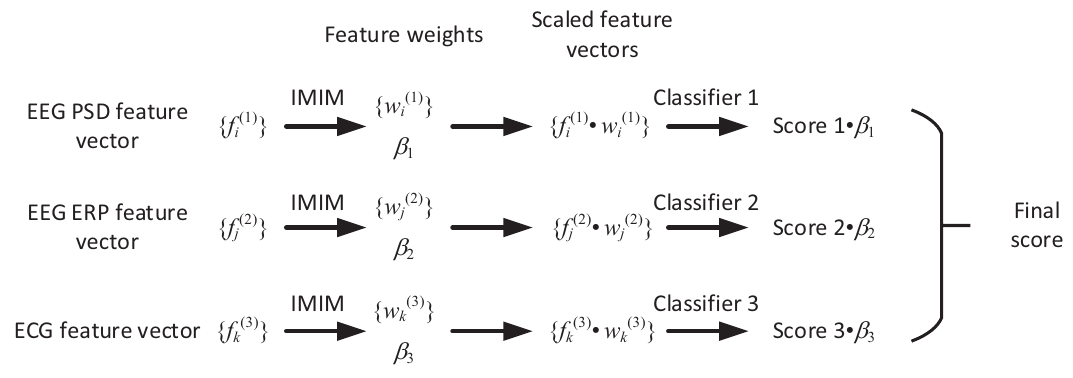
Figure 10. The framework of decision level fusion based on